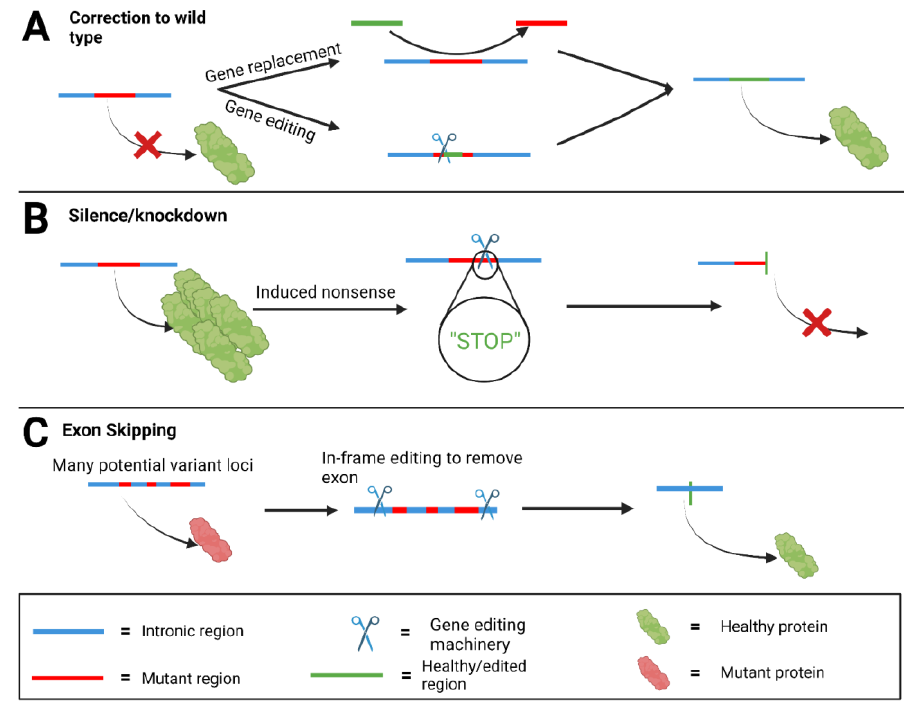
Figure 2. Overview of correction approaches to genetic disorders. Mutated genes and proteins (red) can be treated through several genetic correction methods, creating less harmful genes and proteins (green). ( A ): Mutant genes can be corrected to the wild type using gene editing tools or gene addition therapy. ( B ): Hypermorphic mutations can be silenced through the induction of a ‘STOP’ codon. ( C ): Where there are in-frame exons of a gene of which many possible disease-causing variants have been identified, the entire exon can be removed with gene editing to restore healthy protein function. Created with BioRender.